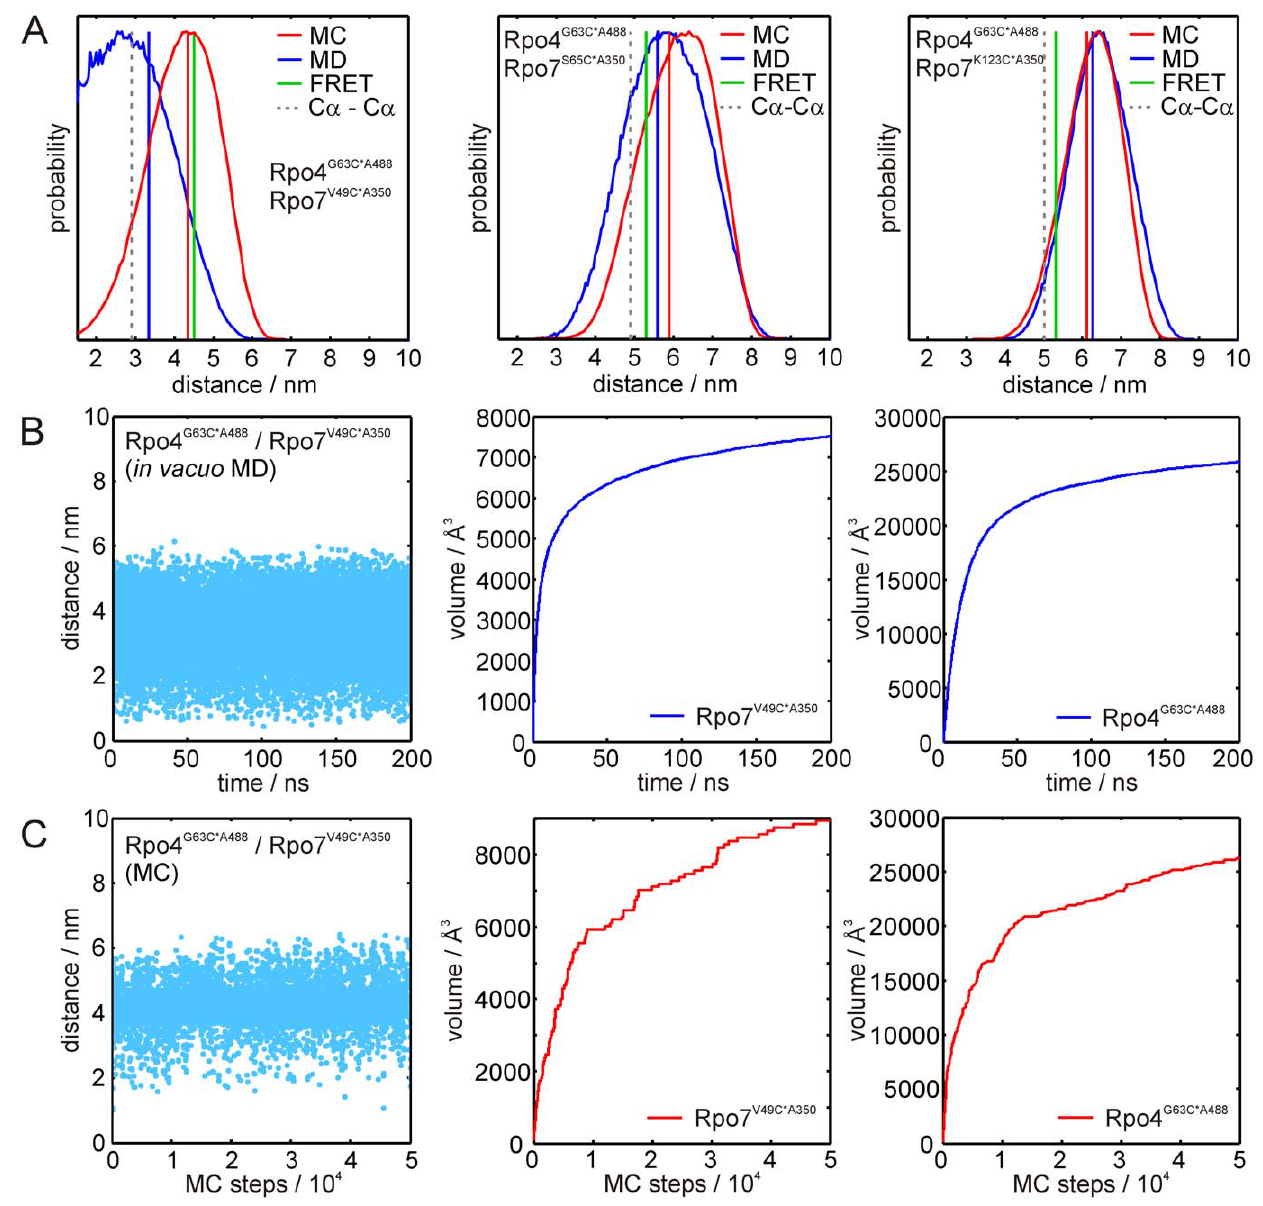
Figure 4. Results of the FRET label simulations. (A) Distance distributions for the label pairs Rpo4 G63C*A488 /Rpo7 V49C*A350 (left), Rpo4 G63C*A488 / Rpo7 S65C*A350 (center) and Rpo4 G63C*A488 /Rpo7 K123C*A350 (right). Distances obtained from the FRET experiments are indicated by green vertical lines, distance distributions obtained from the MD simulations and the MC samplings are shown in blue and red, respectively. Blue and red vertical lines represent expected FRET distances calculated from the respective simulated distance distributions. C a -C a distances obtained from the crystal structure are marked by grey lines. (B) Results of the MD simulation for Rpo4 G63C*A488 /Rpo7 V49C*A350 . Left panel: Distance trajectory; center and right panel: Volume sampled by the FRET labels over simulation time for labels Rpo7 V49C*A350 and Rpo4 G63C*A488 , respectively. (C) Results of the MC sampling for Rpo4 G63C*A488 /Rpo7 V49C*A350 . Left panel: Distance trajectory; center and right panel: Volume sampled by the FRET labels over the number of MC sampling steps for labels Rpo7 V49C*A350 and Rpo4 G63C*A488 ,